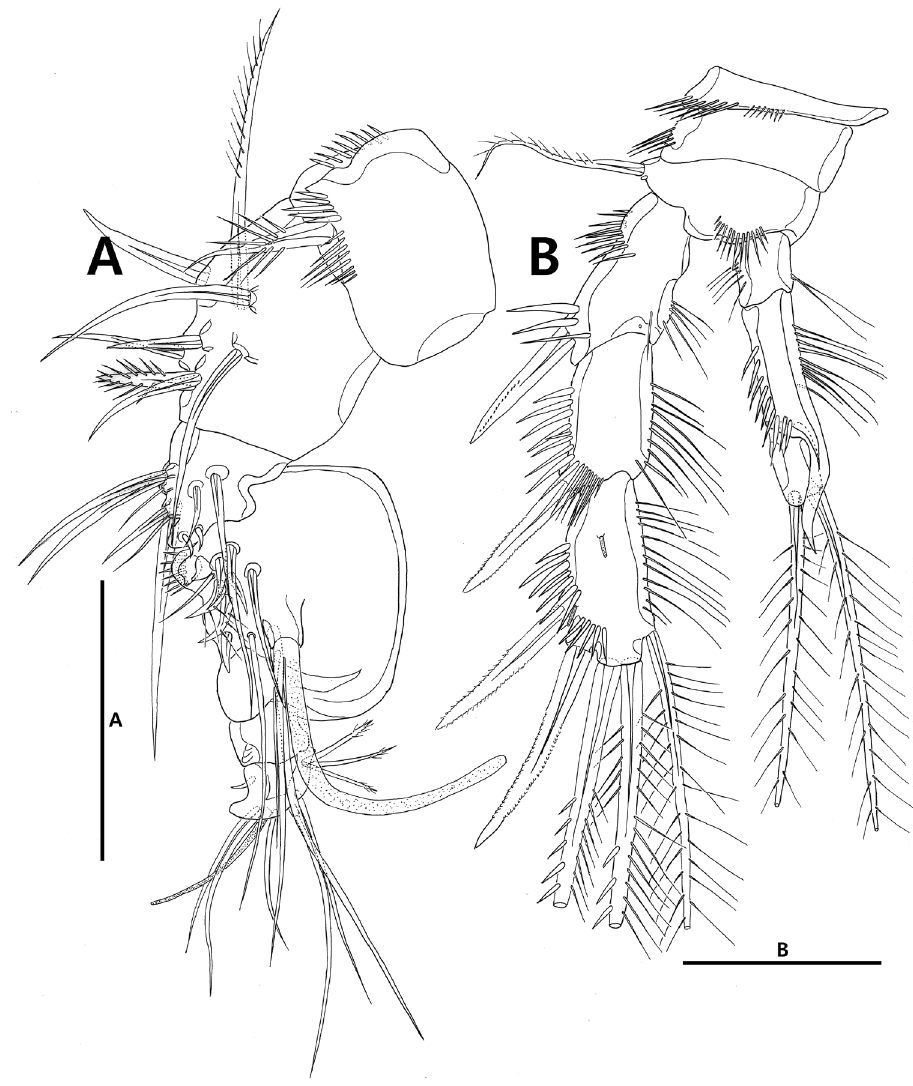
Figure 7. Strongylacron glabrum sp. n. male. A antennule B P3. Scale bars 50 µm.